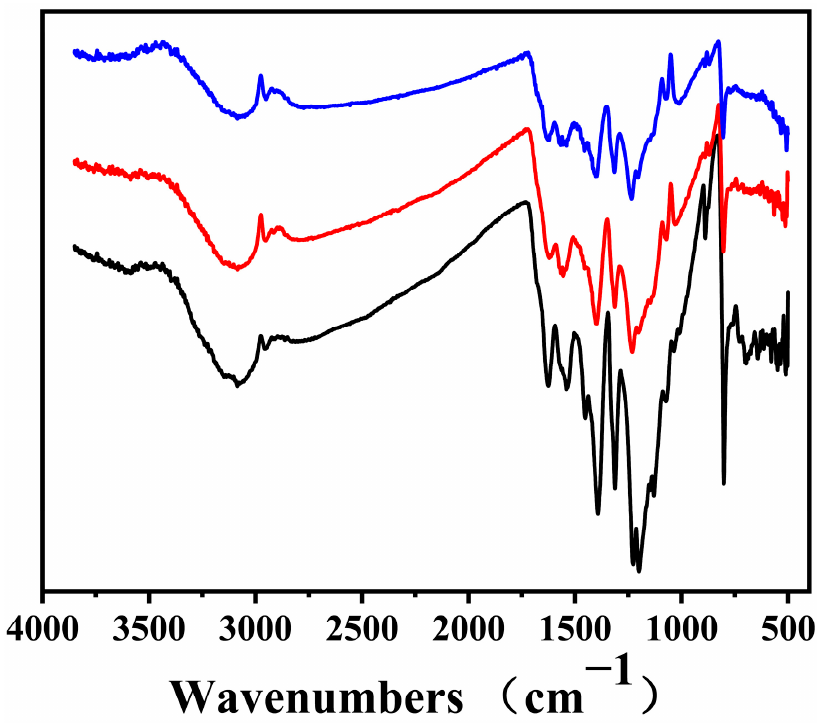
Figure 5. The FTIR spectra of g-C 3 N 4 , g-C 3 N 4 /CF, and g-C 3 N 4 /CF co-immobilized enzymes (g- C 3 N 4 /CF co-immobilized enzymes: blue line. g-C 3 N 4 /CF: red line. g-C 3 N 4 : black